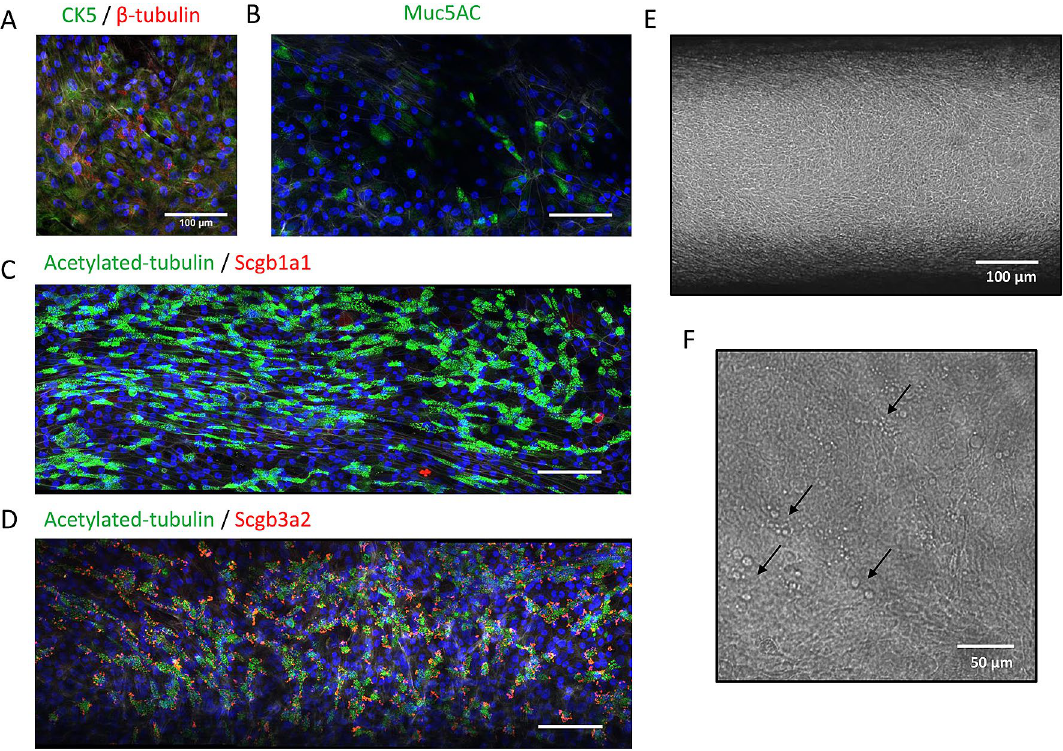
Figure 3. Healthy PREDICT96-ALI airway model with freshly harvested epithelial cells from research bronchoscopies. Panels illustrating establishment of mature tissue with pseudostratified morphology, approximately 30–50 µm, thick from freshly harvested airway epithelial cells obtained from living research bronchoscopy donor D. ( A–D ) ×40 images showing basal cell populations (CK5, green), goblet cells (Muc5AC, green), ciliated cells (acetylated tubulin, green; β-tubulin, red), and club cells (Scgb1a1, red; Scgb3a2, red) counterstained with nucleic acid (DAPI, blue) and actin (phalloidin, grey) with scale bar 100 µm, ( E ) ×10 phase contrast image of mature tissue at 28 days at an ALI with scale bar 100 µm, and ( F ) ×40 phase contrast image of mucus droplets (black arrows) on surface of mature tissue at 28 days at an ALI with scale bar 50 µm. Cells are characterized by robust ciliary beat (see supplementary video) and mucociliary